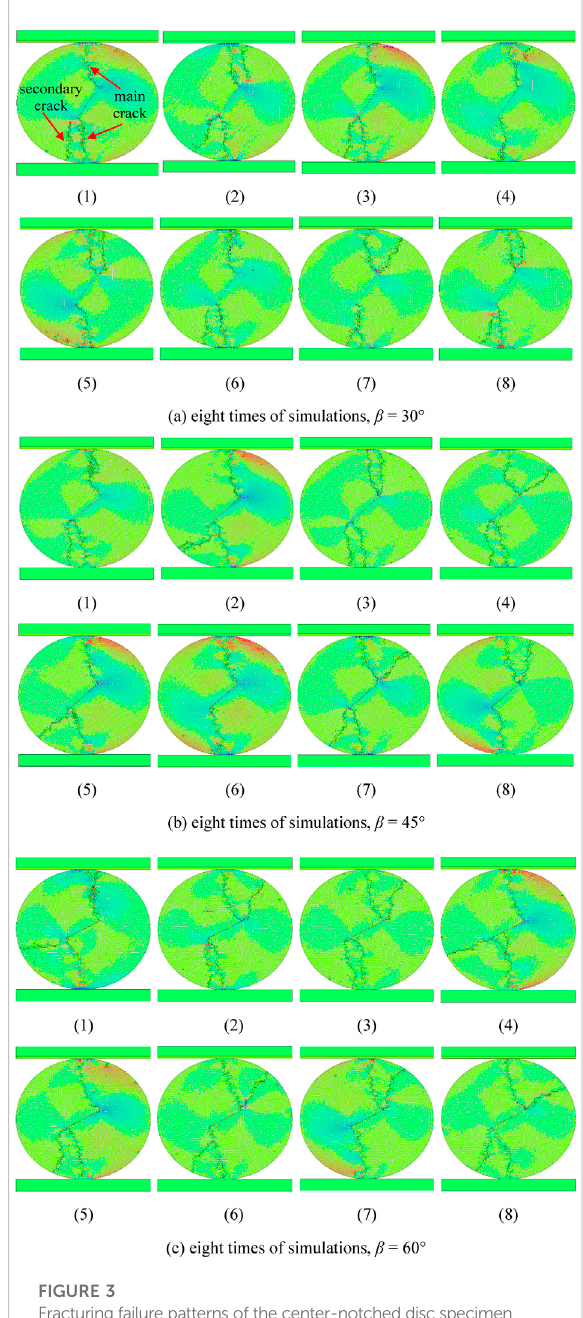
FIGURE 3 Fracturing failure patterns of the center-notched disc specimen with different β under the same heterogeneity degree ( m = 5).